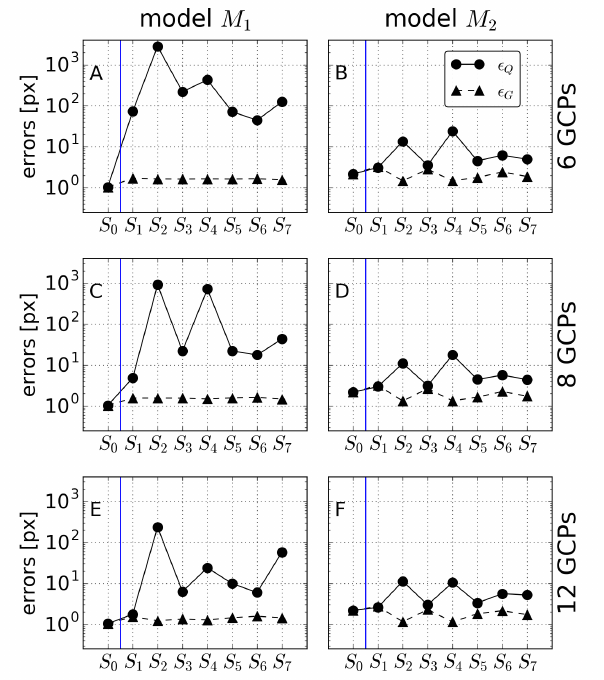
Figure 10. Errors (cid:101) Q and (cid:101) G for angle A 1 for different numbers of GCPs (for sets S 1 to S 7 ): 6 GCPs ( A , B ); 8 GCPs ( C , D ); and 12 GCPs ( E , F ) and for models M 1 ( A , C , E ) and M 2 ( B , D , F